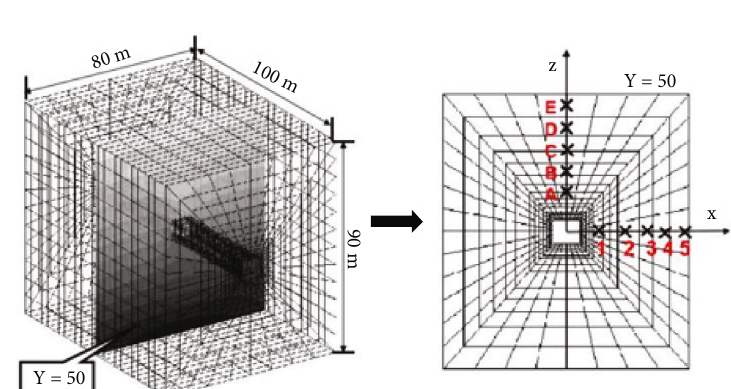
Figure 2: Numerical calculation model and the schematic diagram showing the measuring point